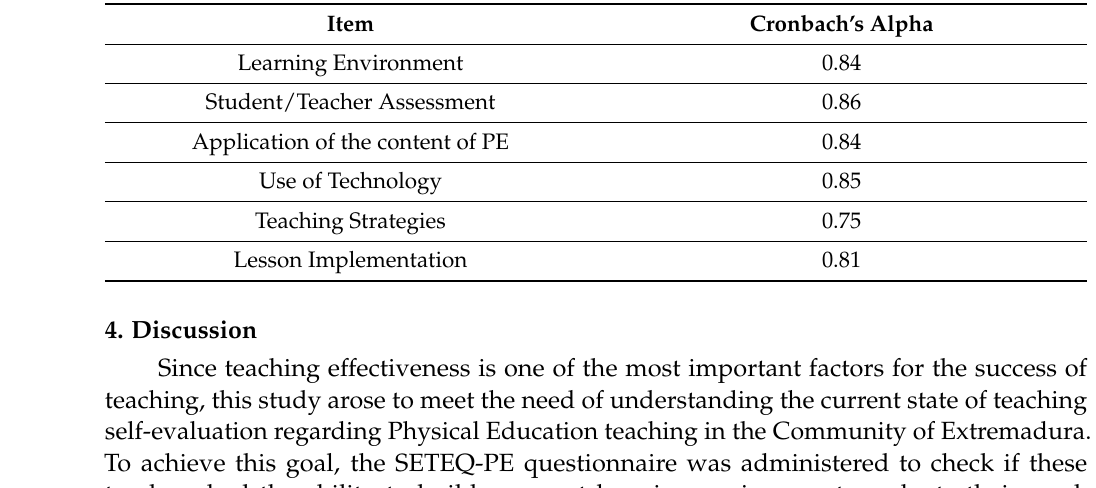
Table 4. Reliability values of the dimensions of the